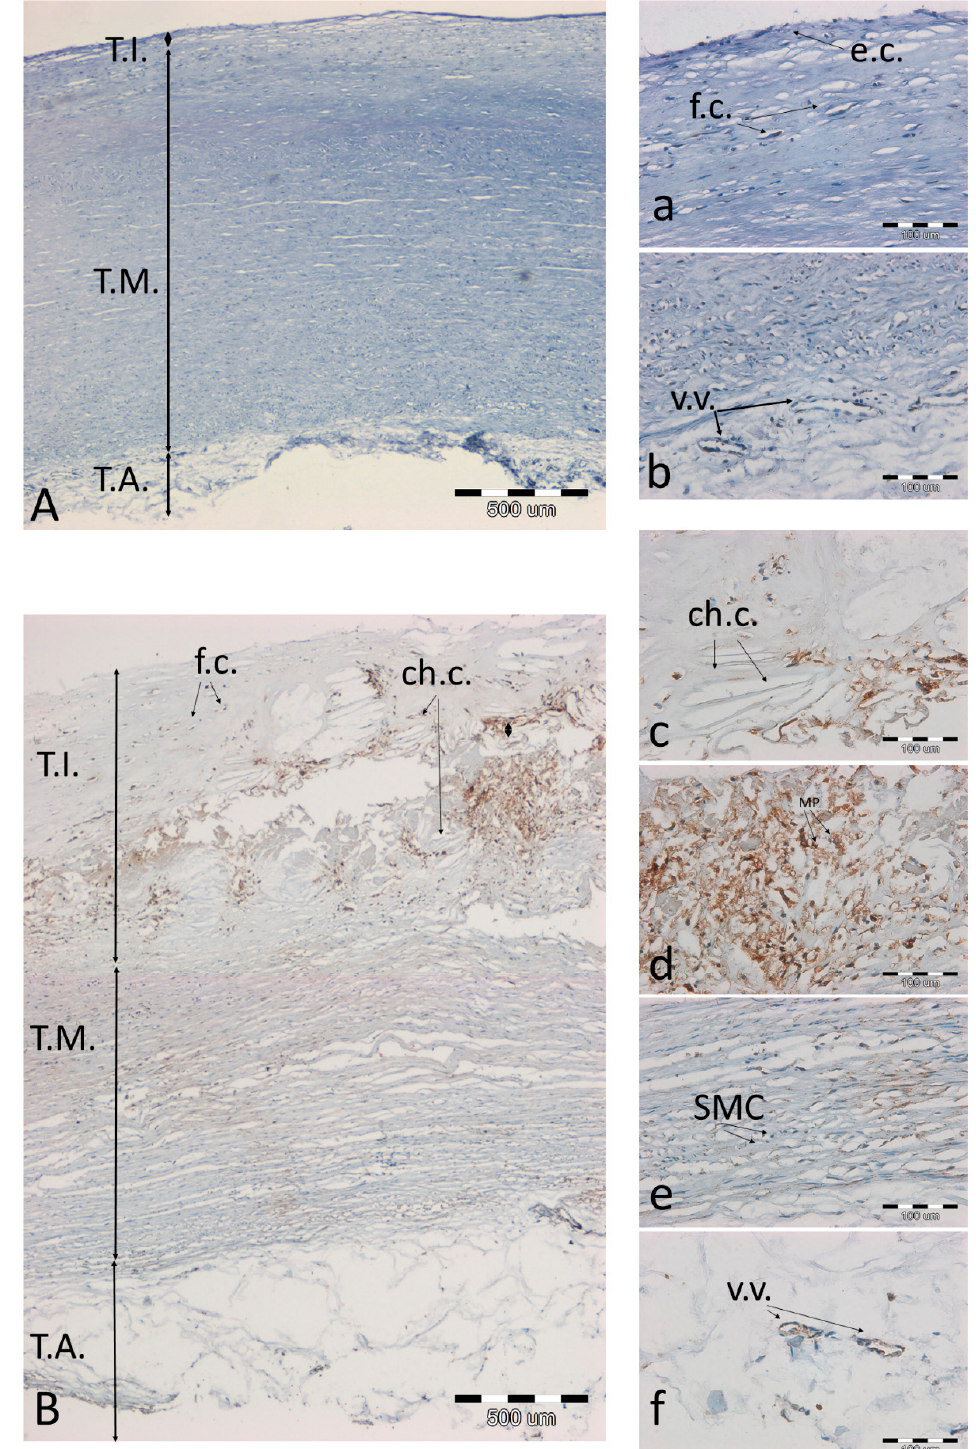
Figure 6. Immunodetection of the SOD2 antigen in a representative artery with a low degree of atherosclerosis ( A ,( a , b ) and high degree of atherosclerosis ( B ,( c – f )). A , B —the entire aortic section, 40× magnification, scale bar 500 μ m; ( a – f )— magnification 200×, scale bar 100 μ m. Abbreviations in figures: T.A.—tunica adventitia; T.I.—tunica intima; T.M.—tunica media; ch.c.—cholesterol clefts; v.v.—vasa vasorum; f.c.—foam cells; SMC—smooth muscle cells; e.c.—endothelial cells; a.—adipocytes; ECM—extracellular matrix; MP—macrophages.